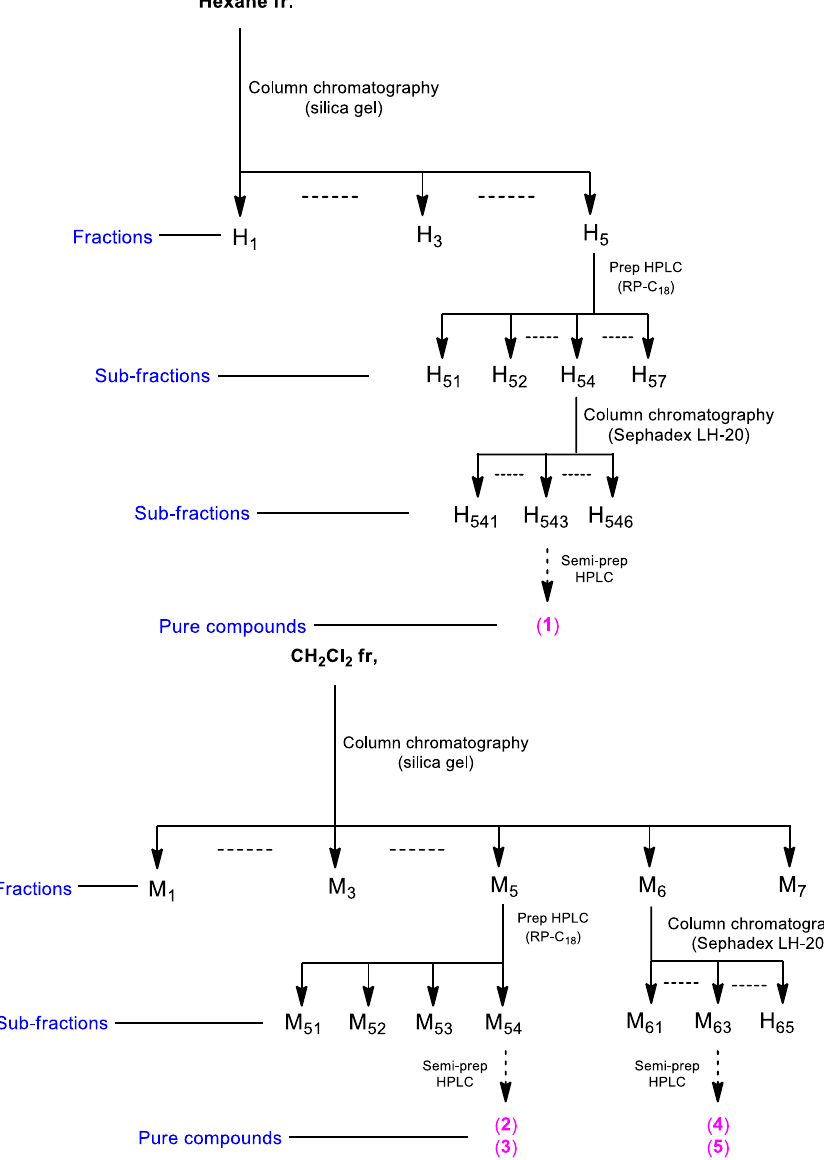
Figure 2. The separation scheme of compounds 1 – 5 .